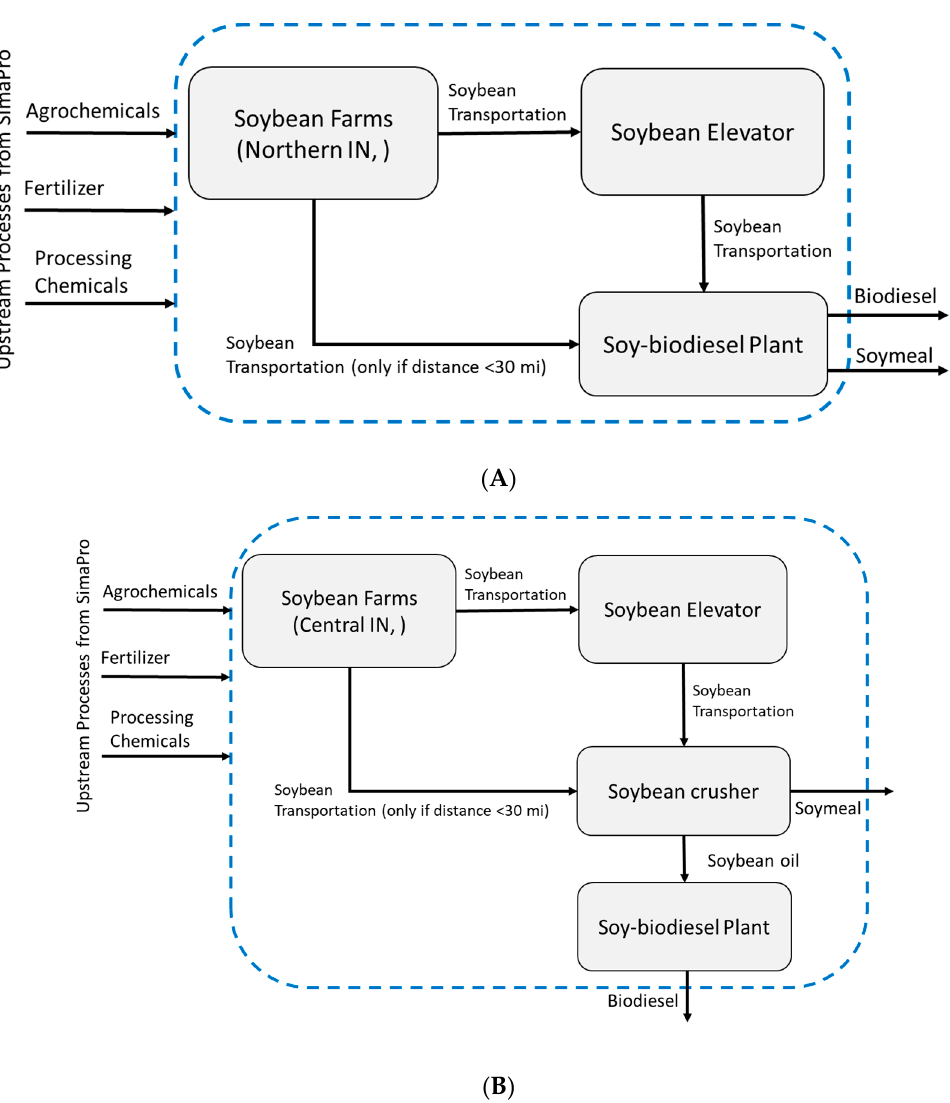
Figure 1. ( A ) Cradle-to-Gate System boundary for northern Indiana biodiesel production; ( B ) Cradle- to-Gate System boundary for central Indiana biodiesel production